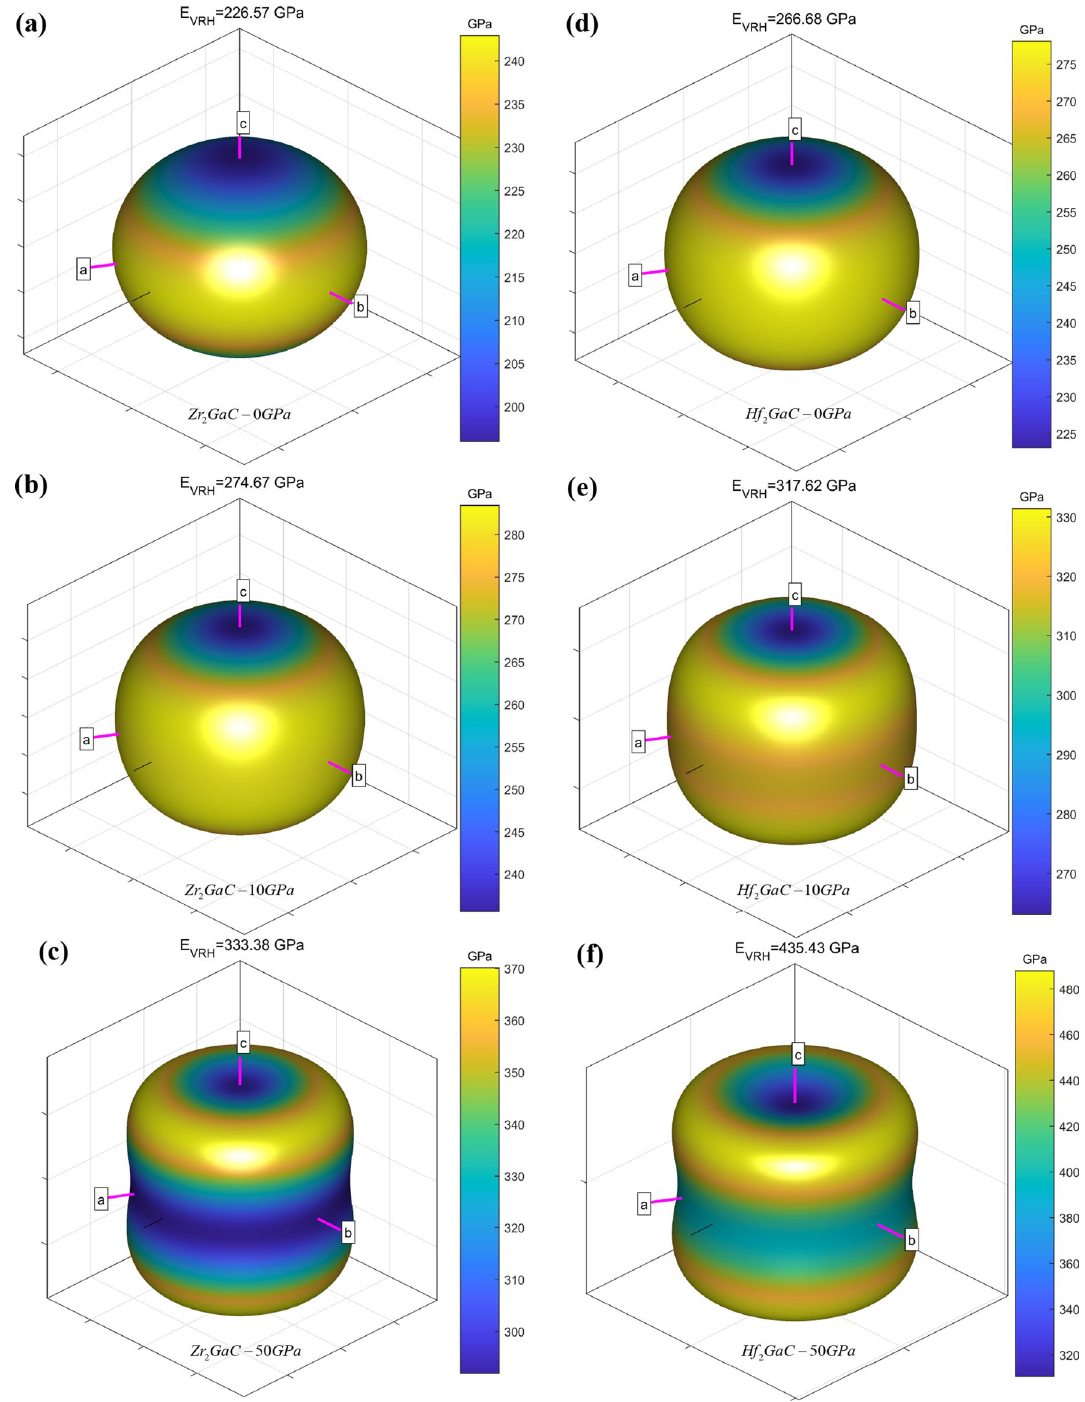
Figure 14. 3D plot of Young’s modulus (E) surface of M 2 GaC MAX phase (M = Zr, Hf) at various